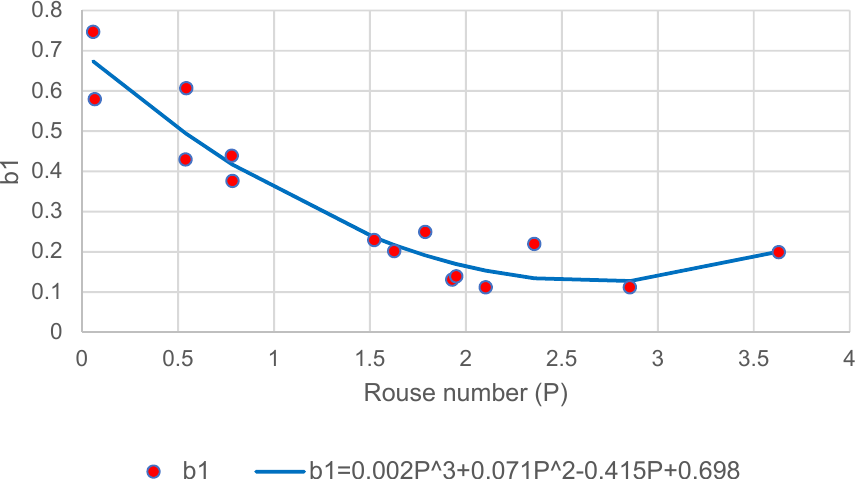
00.10.20.30.40.50.60.70.8 Figure 5. Rouse number vs. coefficient b 1 using SVM ( R 2 = Figure 5. Rouse number vs. coefficient 𝑏 (cid:2869) using SVM ( 𝑅 (cid:2870) = 0.9148 ). Figure 6. Rouse number vs. coefficient 𝑎 (cid:2869) using KNN ( 𝑅 (cid:2870) = 0.61 ).